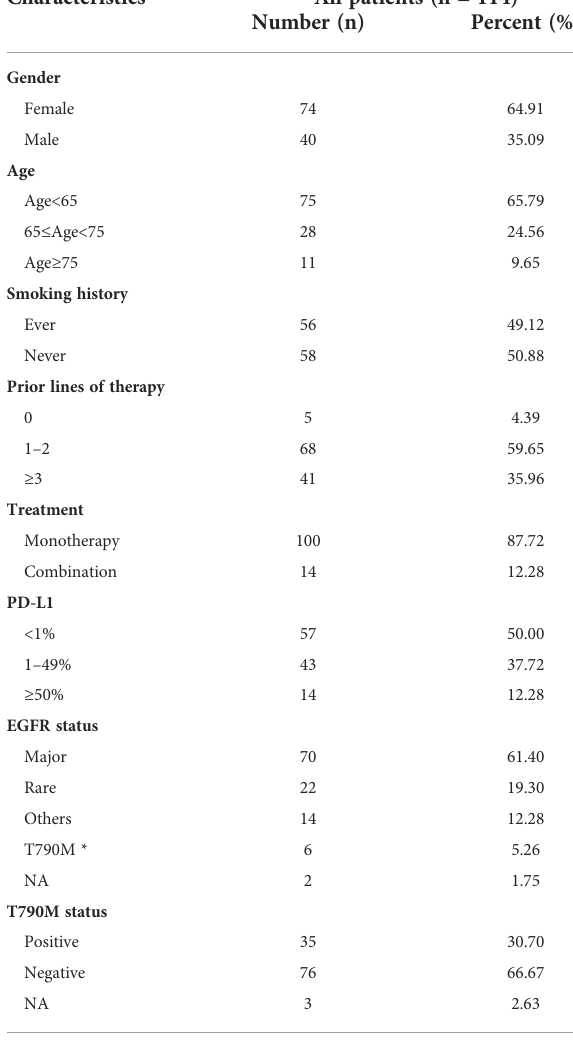
TABLE 1 Patients ’